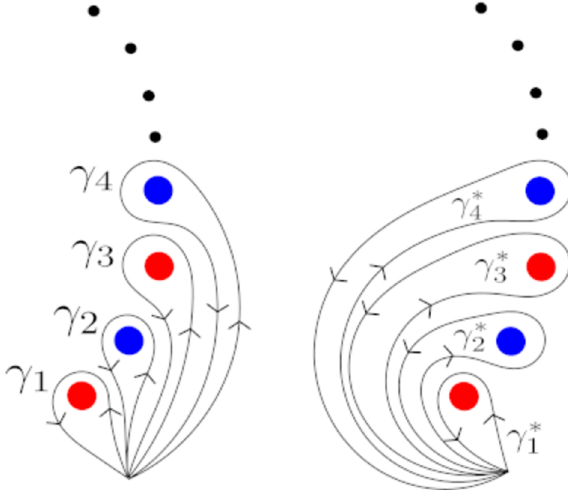
Figure 5 . Left: loops γ n encircling the defects arranged in a circle from the ‘outside’. Right: different choice of loops γ ∗ encircling the defects from the n